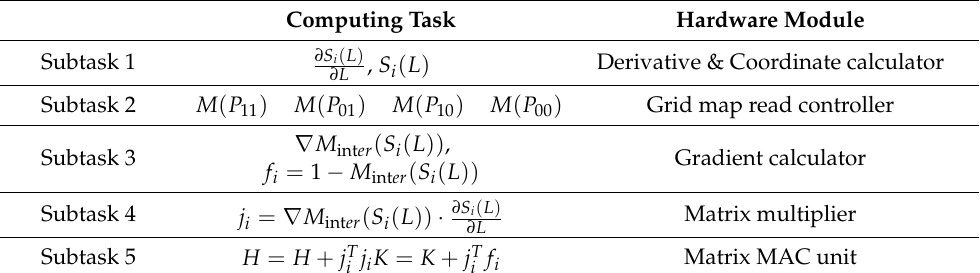
Table 2. Segmentation of Computation Tasks in the Fine Match Process. Computing Task Hardware